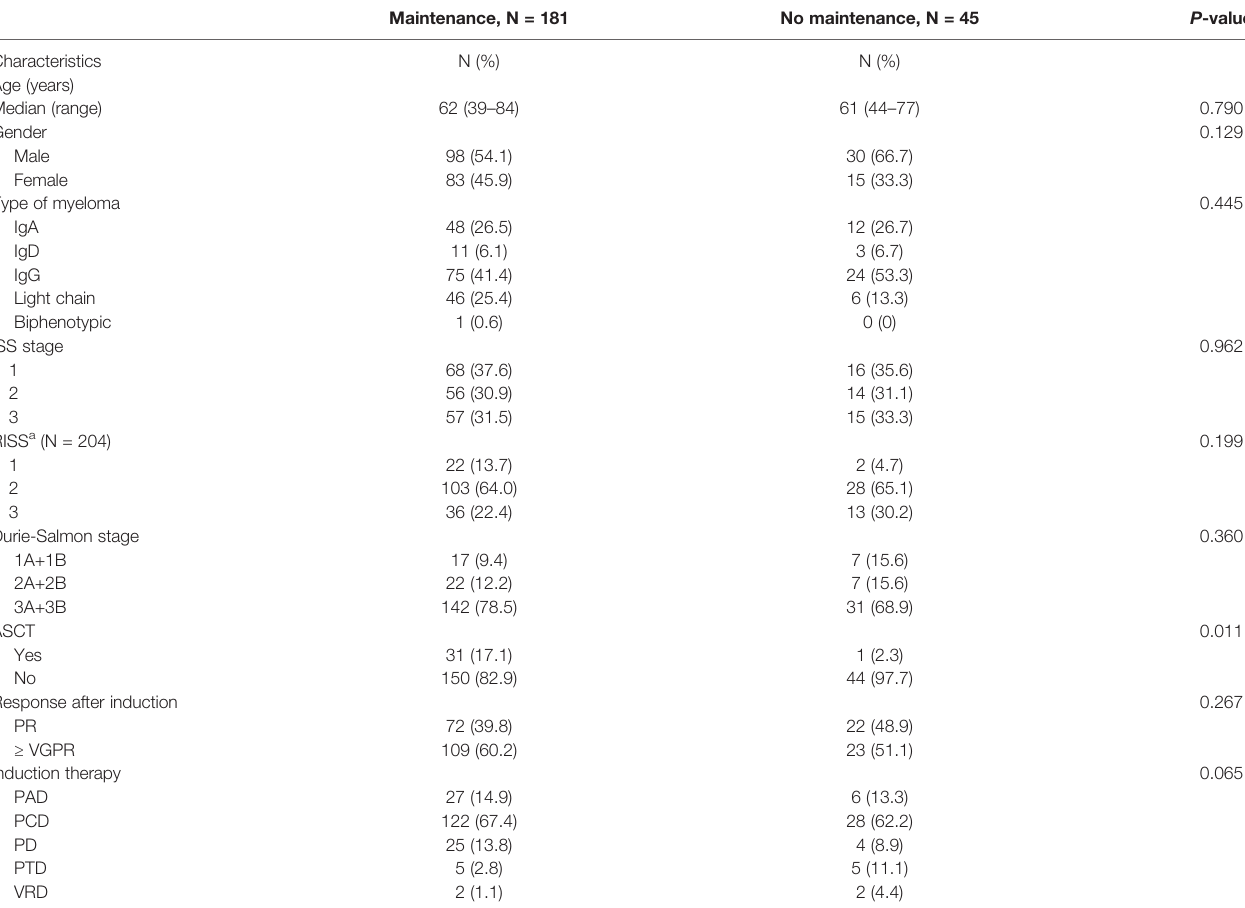
TABLE 1 | Baseline characteristics of NDMM patients with or without maintenance